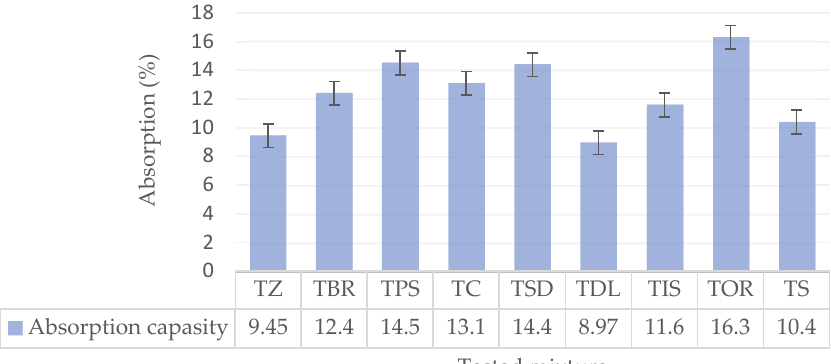
Figure 13. Absorption capacity value for the fired tested mixtures.